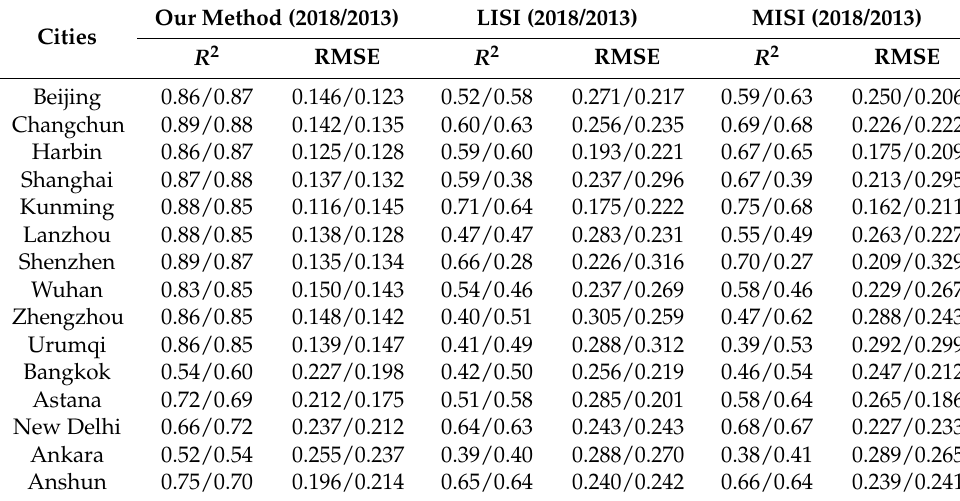
Table 5. Predicted accuracy of AISP in typical